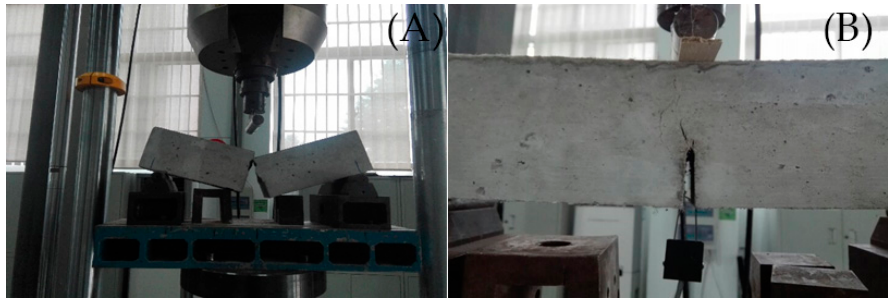
Figure 3. Fracture behavior: ( A ) Catastrophic (GP0 specimen); ( B ) Ductile (GP5 specimen).